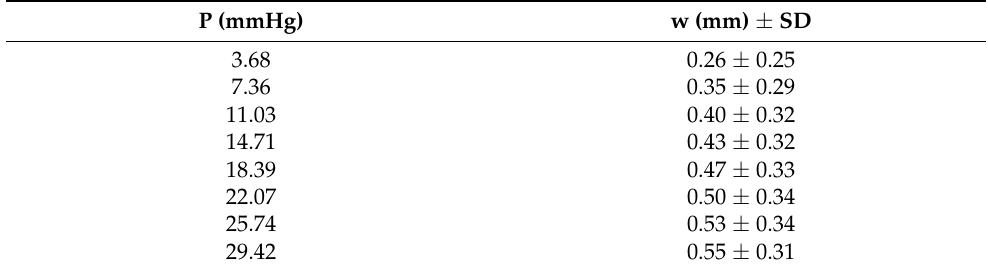
Table 4. Apex displacement, w(mm) for every applied pressure, P (mmHg).